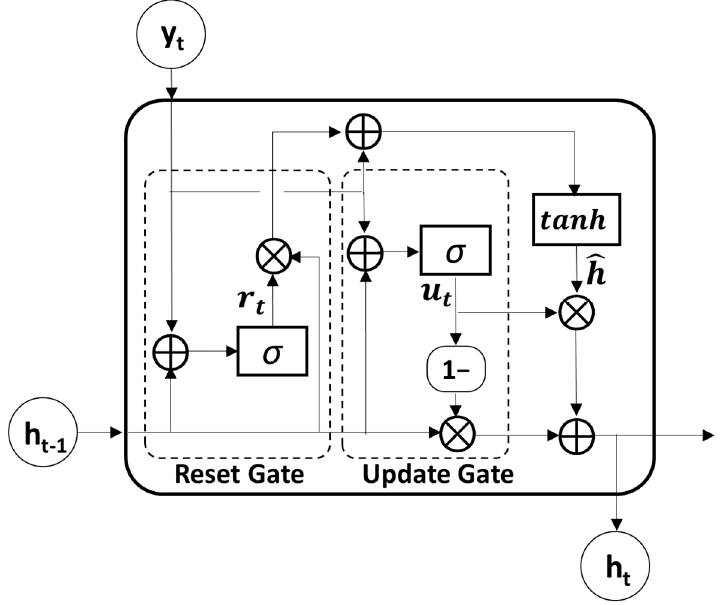
Figure 2. The structure of gated recurrent unit (GRU). The symbol ⊗: the element-wise multiplica-